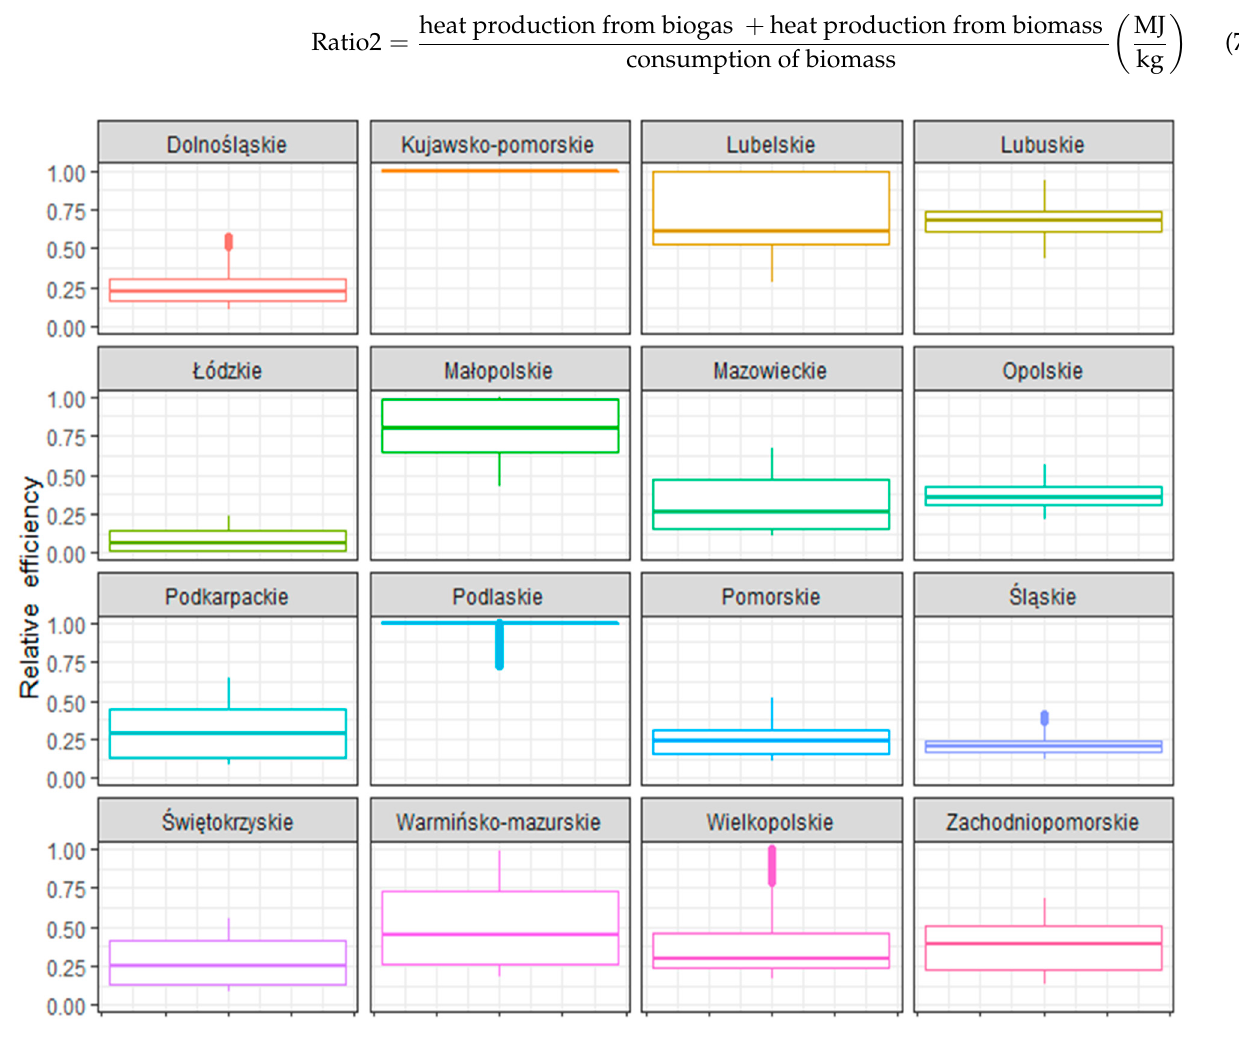
Figure 3. Boxplots of relative efficiency obtained through simulation for voivodeships in 2018.